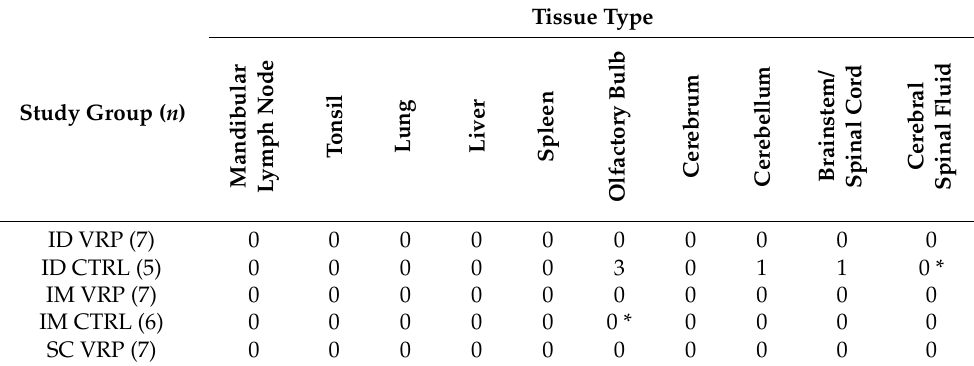
Table 2. Number of NHPs with Detectable Amplification above Lower Limit of Detection of WEEV CBA87 Viral RNA in Tissue and Cerebral Spinal Fluid by RT-PCR. Tissue